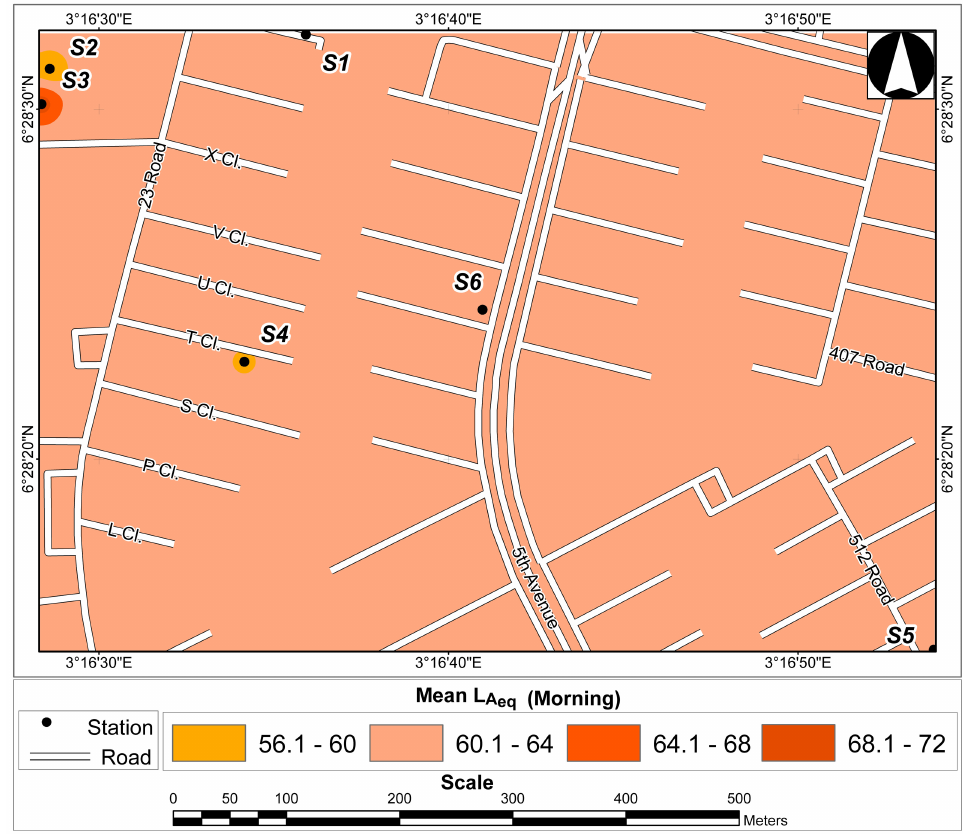
Figure 5: Mean L Aeq for the morning period derived by kriging interpolation Table 3: Descriptive statistics of L Aeq noise levels –